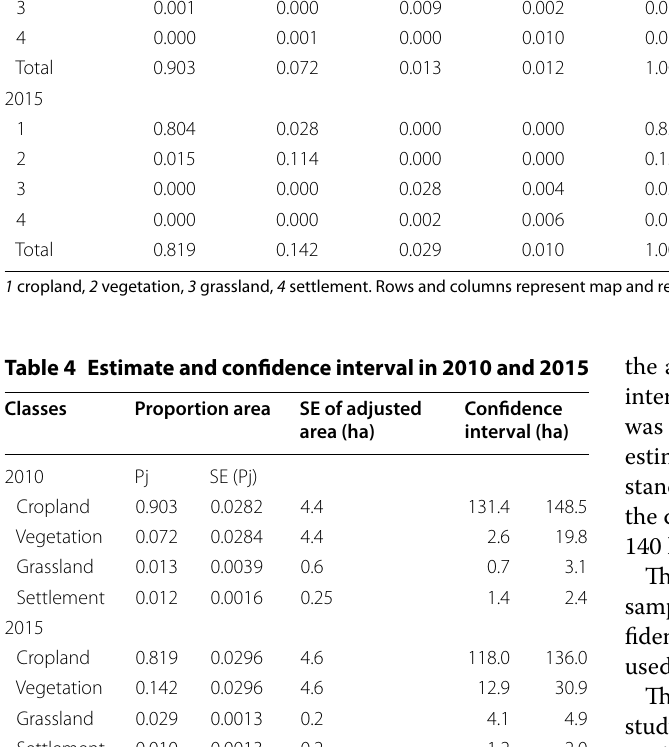
Table 3 Estimated error matrix based on Table 2 with cell entries expressed as the estimated proportion of area and accuracies Classes